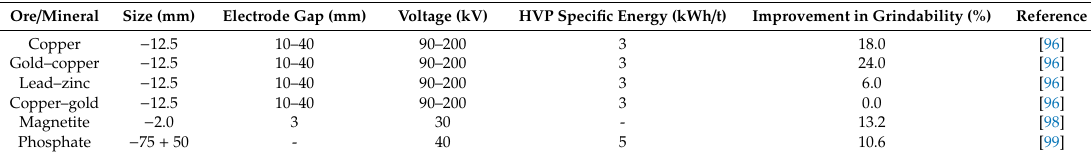
Table 9. Summary of the electrical